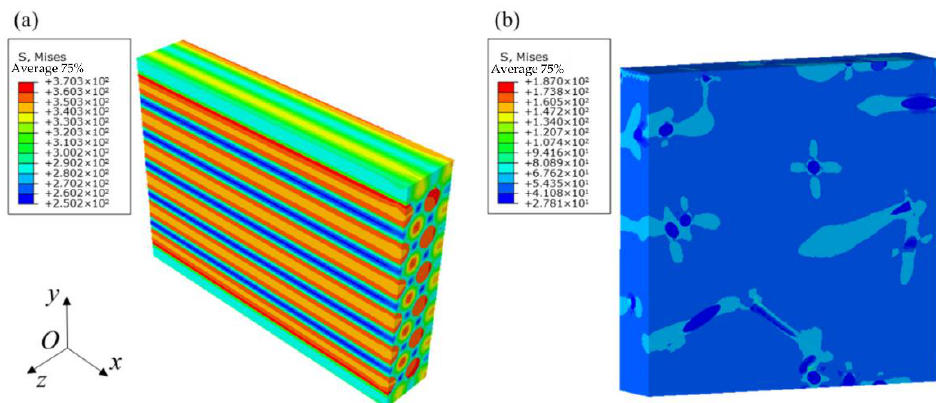
Figure 6. Mises stress contours for a shear strain γ yz of 1%. (Unit: MPa) ( a ) unidirectional fibers ( b ) short-cut fibers.